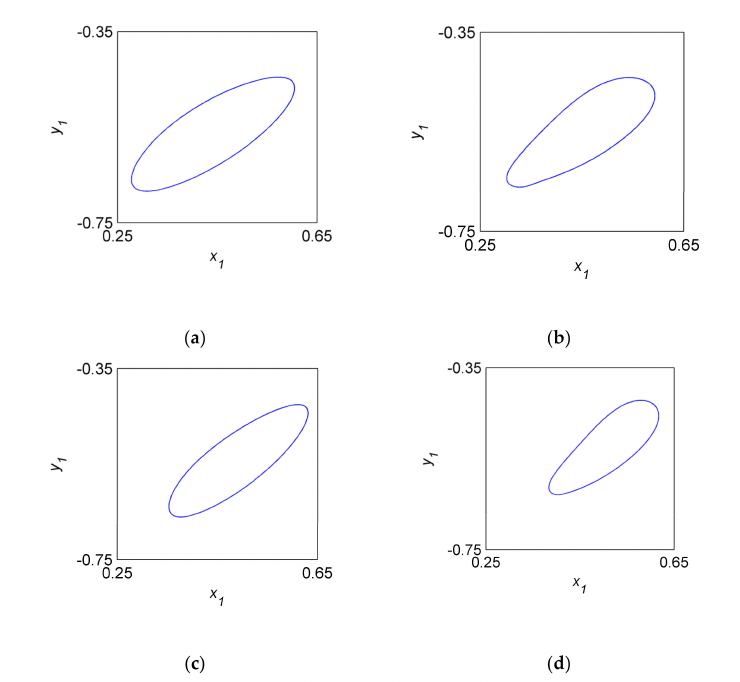
Figure 6. Trajectories of the orbit of shaft center of o 1 when ω = 350 rad/s. ( a ) The oil-filmed system.